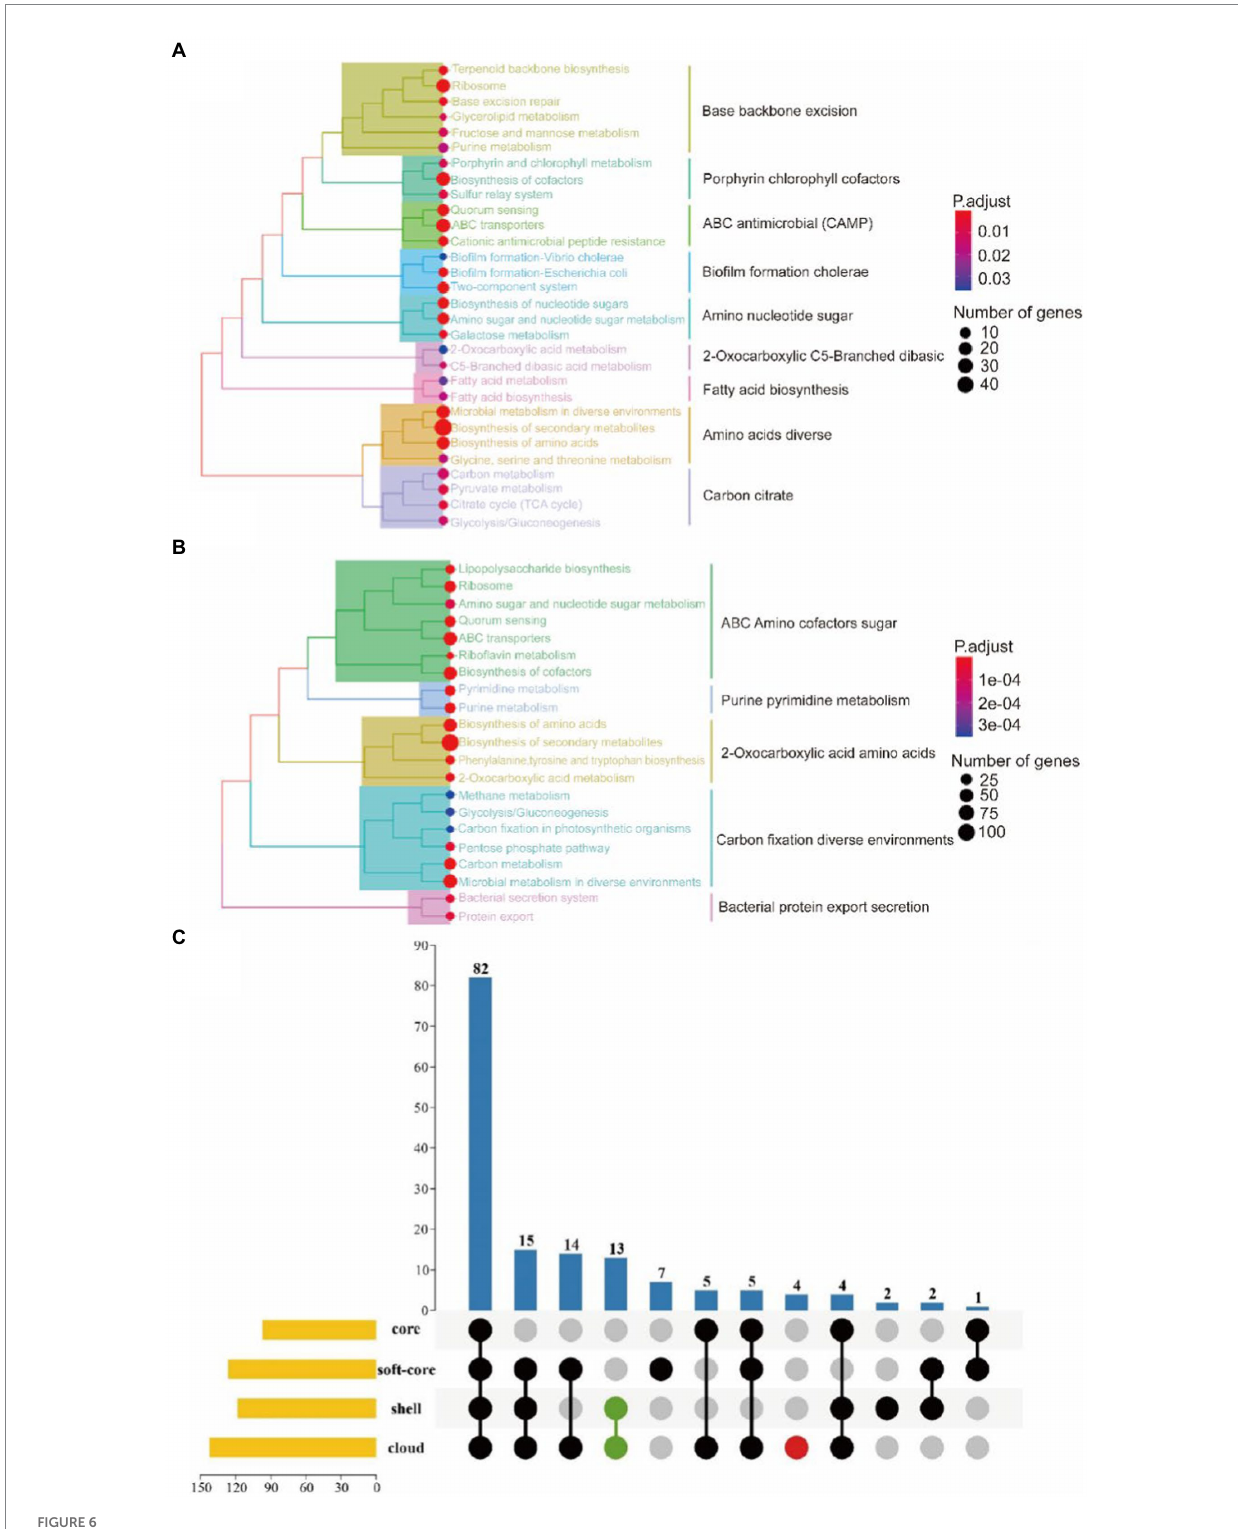
FIGURE 6 KEGG enrichment of the core genome. (A) Represents the core gene. (B) Represents the soft-core gene. (C) Represents KEGG enrichment for the four classes of gene sets. The yellow bar chart on the left represented the number of KEGG metabolic pathways involved in each of the four gene sets. The bar chart at the top and the dot chart at the bottom together explained the number of KEGG metabolic pathways involved in different groups of the four gene sets. Additionally, green and red were used to represent the accessory genomes and cloud genes,